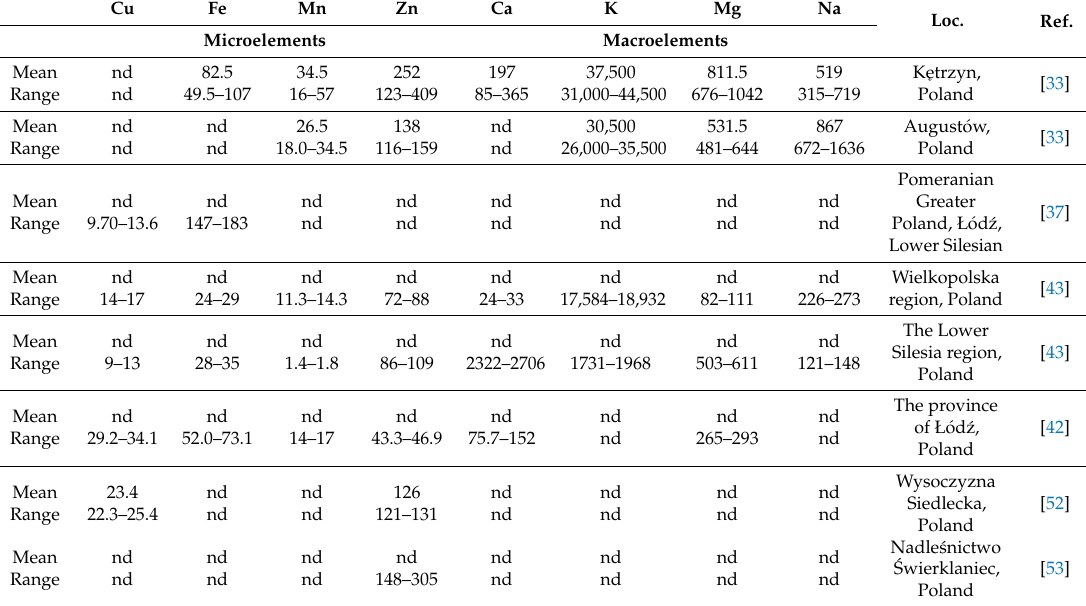
Table 4. Minerals in Boletus badius (adapted) [mg / kg